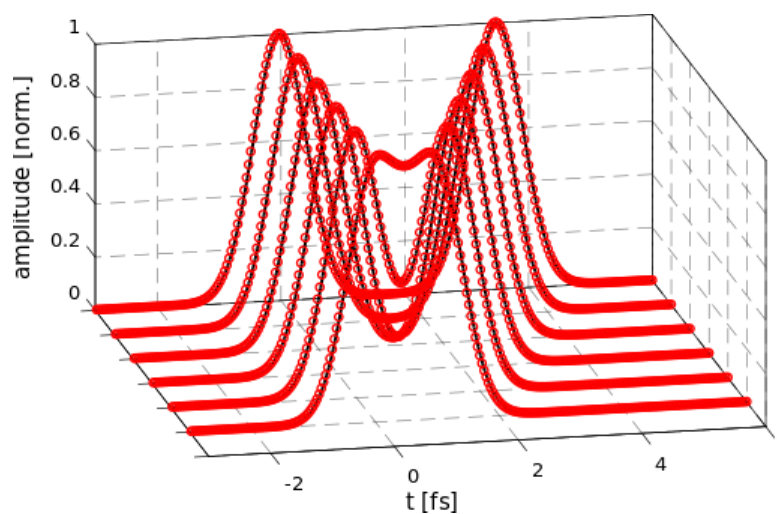
Figure 2. Ptychographic reconstruction of X-ray double pulses. Each pulse is 1 fs long and the time delay between the two replica increases from 1 fs to 3.5 fs in steps of 0.5 fs. In all cases, the reconstructed X-ray waveform (red circles) matches the original waveform (black curve) extremely